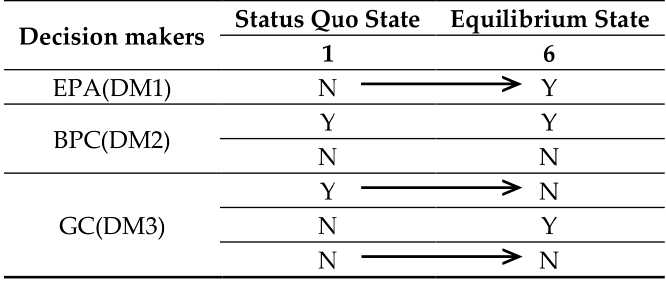
Figure 5. Evolution of the conflict from the status quo through an intermediate state to the final resolution.